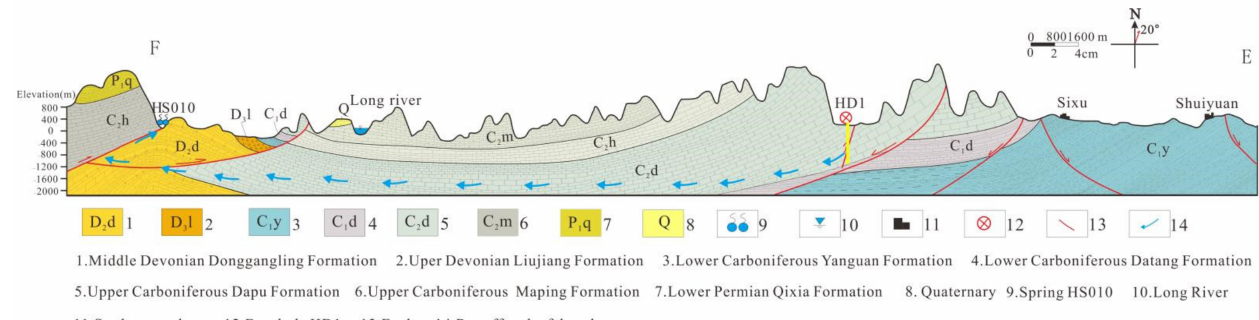
Figure 2. Sectional view of actual geological map of deep karst in Huanjiang sag [16]. (The deep karst groundwater of HD1 well in the northern part of the syncline recharges the karst spring HS010 in the southern part of the syncline through the fracture zone). The plane position of this drawing is shown in Figure